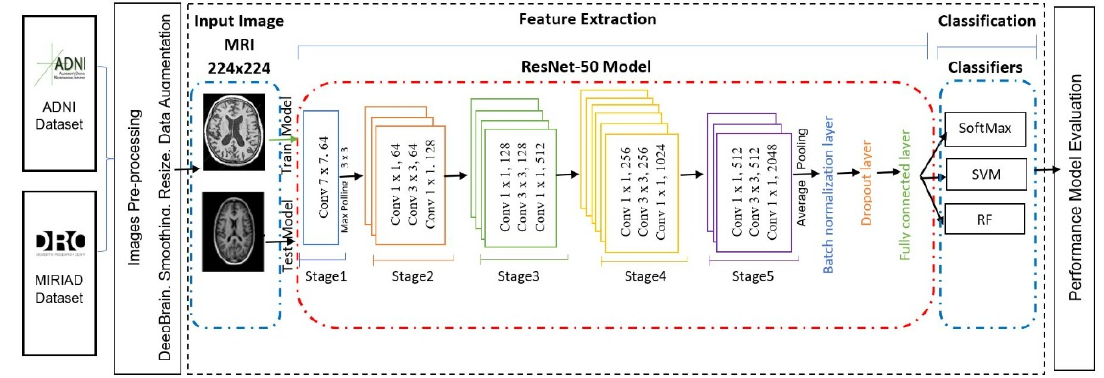
Figure 1. The general structure of the proposed approach.